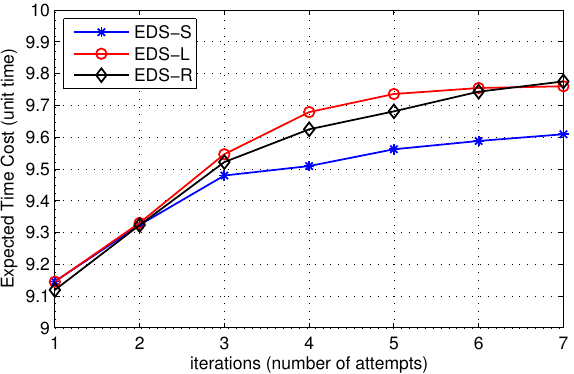
Figure 15. Effect on expected time to locate the destination for different TTL